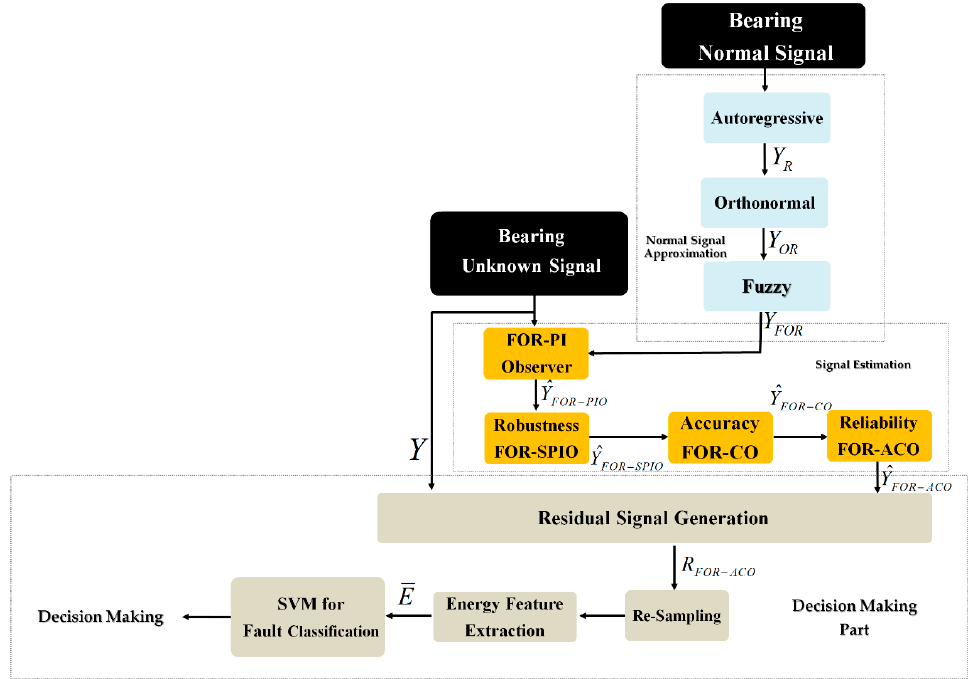
Figure 1. Bearing fault identification using machine learning and adaptive cascade observer by fuzzy orthonormal regressive bearing signal approximation, SVM (support vector machine).